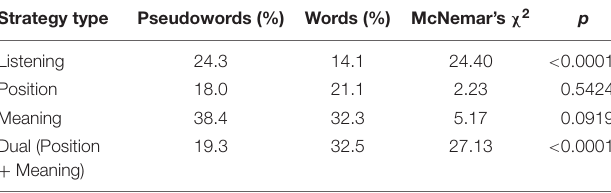
TABLE 5 | Self-reported strategy distribution according to the type of